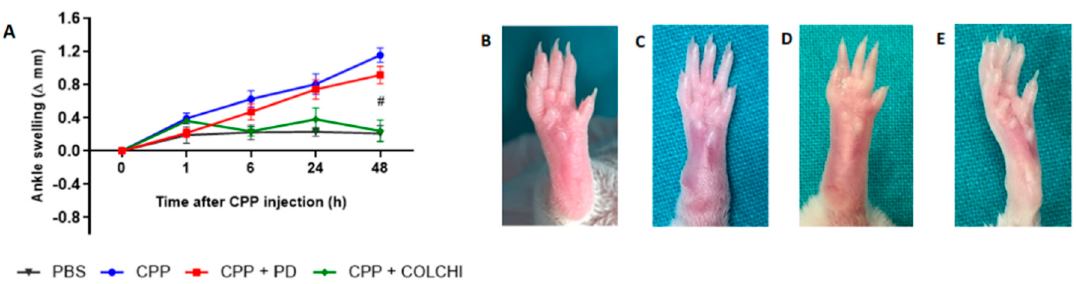
Figure 5. Variation in ankle swelling after CPP crystal injection and drug treatment in the therapeutic group. ( A ) Mice received PD (40 mg/kg) or colchicine (1 g/kg) treatment after the i.a. injection of CPP crystals (0.3 mg/20 μ L) ( n = 8/group). Mann–Whitney test CPP group vs. CPP + colchicine at 48 h, # p < 0.01. Delta swelling at each time point was calculated with respect to the basal point. ( B – E ) Pictures depict ankles at the endpoint of the study (48 h): ( B ) PBS injection; ( C ) CPP injection; ( D ) CPP and therapeutic treatment with PD; ( E ) CPP and therapeutic treatment with colchicine. Leukocyte infiltration, necrosis and edema, and synovitis, all significantly decreased only in mice following the therapeutic treatment with colchicine (Figure 6).